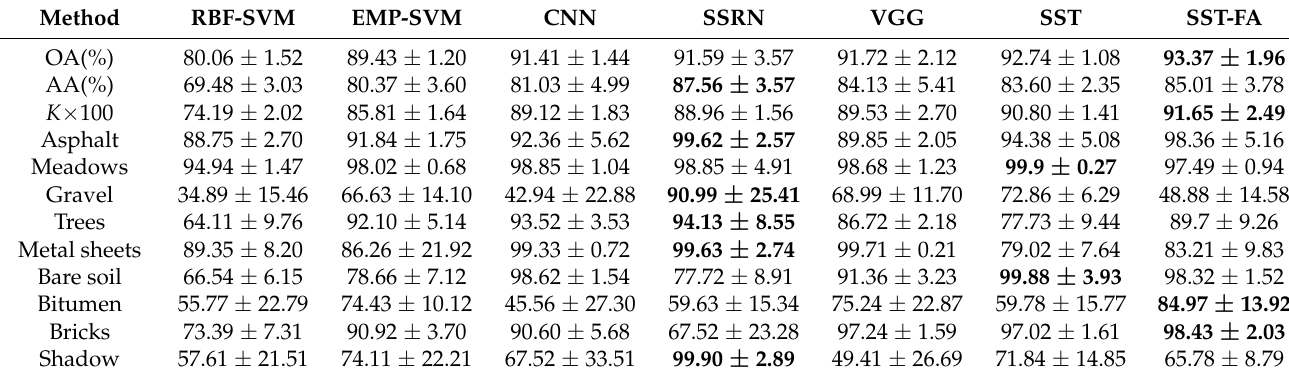
Table 3. Test accuracy with different preprocessing methods on the Pavia